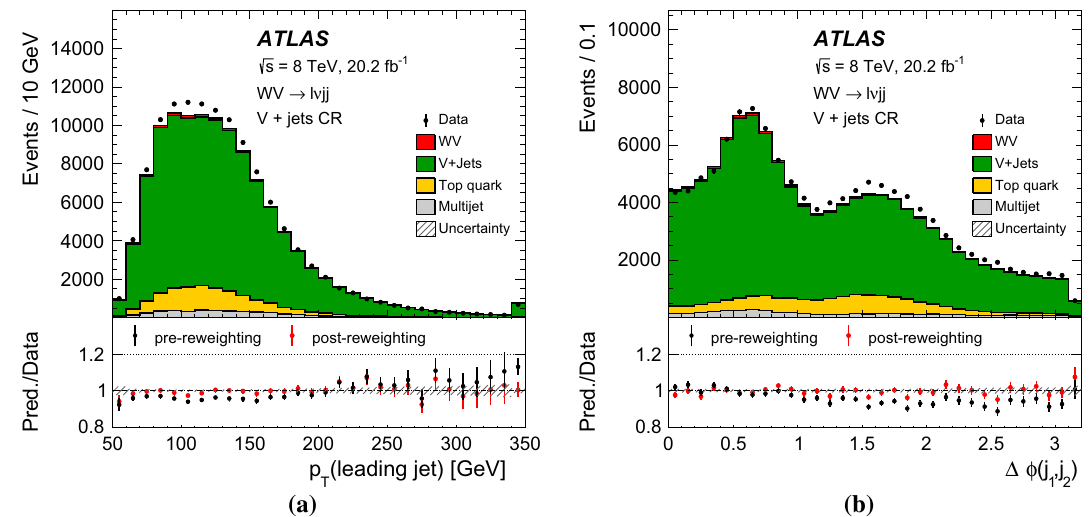
Fig. 1 Comparisons betweenthedataandthepredictioninthe V + jets control region of the WV → (cid:4)ν jj channel. The top panel shows the data and prediction before applying the p T ( j 1 ) and (cid:10)φ( j 1 , j 2 ) kine- matic reweighting to the V + jets predictions. The distributions shown are a p T of the leading jet and b (cid:10)φ between the leading jet and sub-